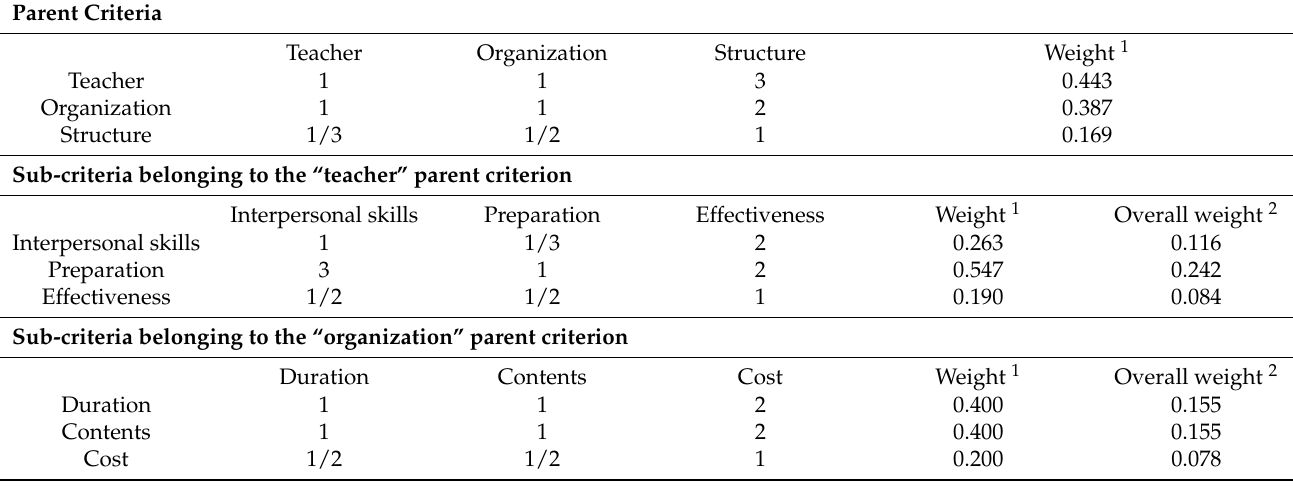
Table 7. Pairwise comparison matrix and AHP priority weights of both parent criteria and